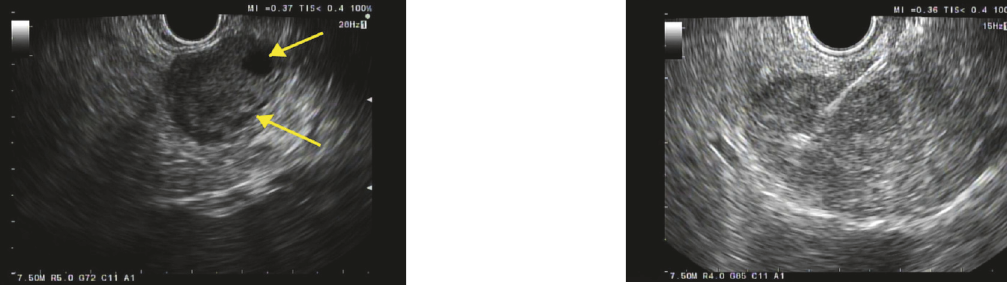
Figure 1: Solid mass with cystic component during an endoscopic ultrasound.